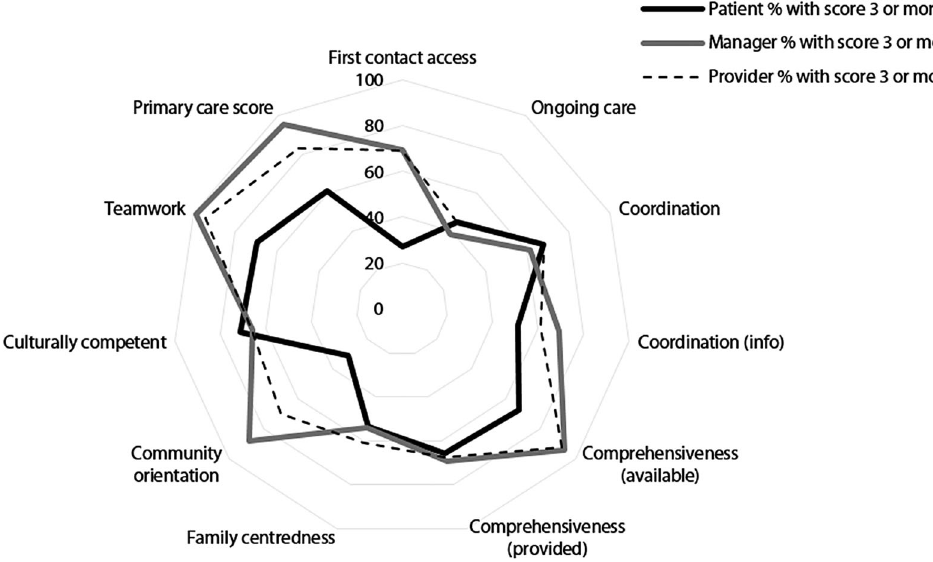
Figure 1: Radar chart of % of scores > = 3 between respondent groups for different primary care